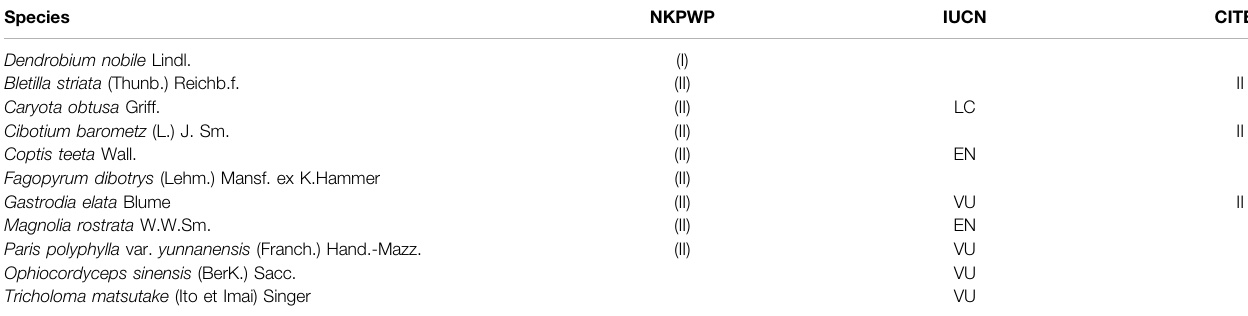
TABLE 4 | Rare and endangered medicinal plants collected by the local people. Species NKPWP Dendrobium nobile Lindl.